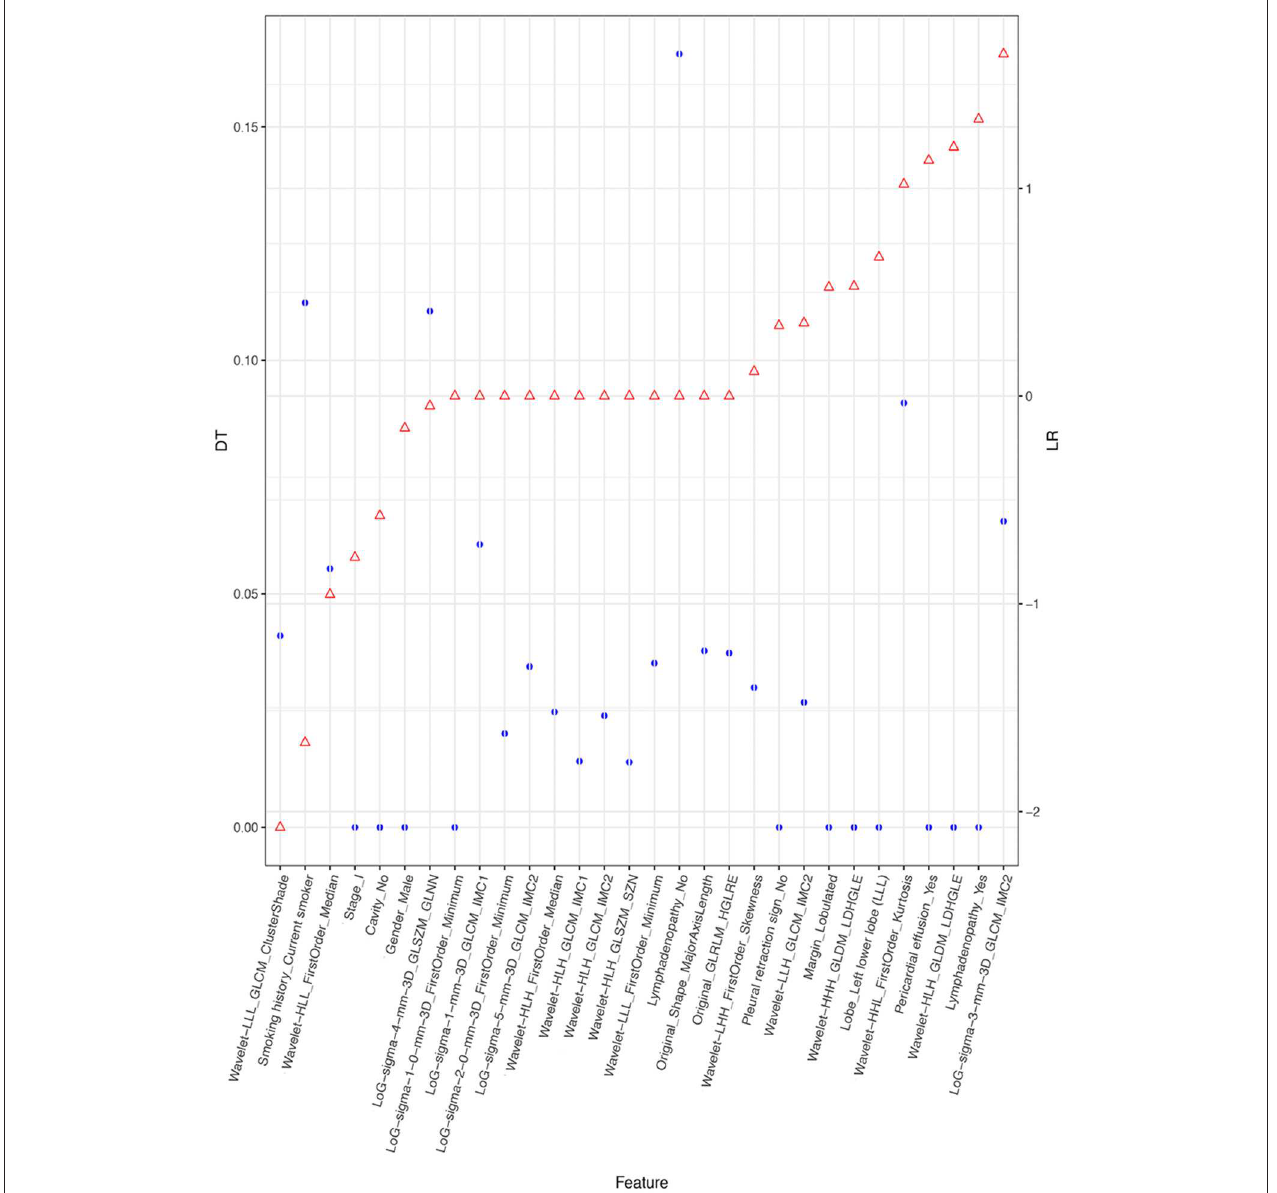
FIGURE 5 | Selected features and their coefficients in the integrated model. The blue dots indicate the coefficients in the DT model. They denote the decrease of the Gini index when such a feature is used in the DT model. A higher DT value suggests a more significant influence. The red dots represent the beta coefficient in the LR model. Since all features were rescaled before the selection procedure, these coefficients are equivalent to the normalized LR coefficients. A higher positive LR coefficient (right side of the figure) suggests a stronger relationship between the feature and ALK mutation, and a higher negative LR coefficient (left side of the figure) suggests a stronger relationship between the feature and ALK-negative